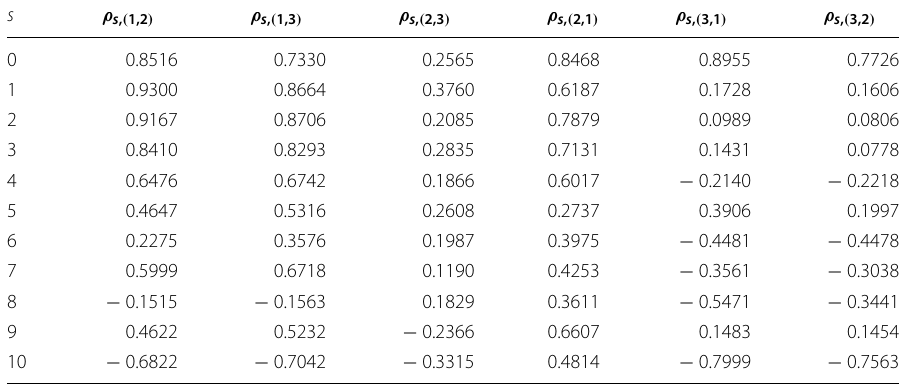
Table 5 Correlation between the incurred claims in one LOB and the paid losses in another LOB